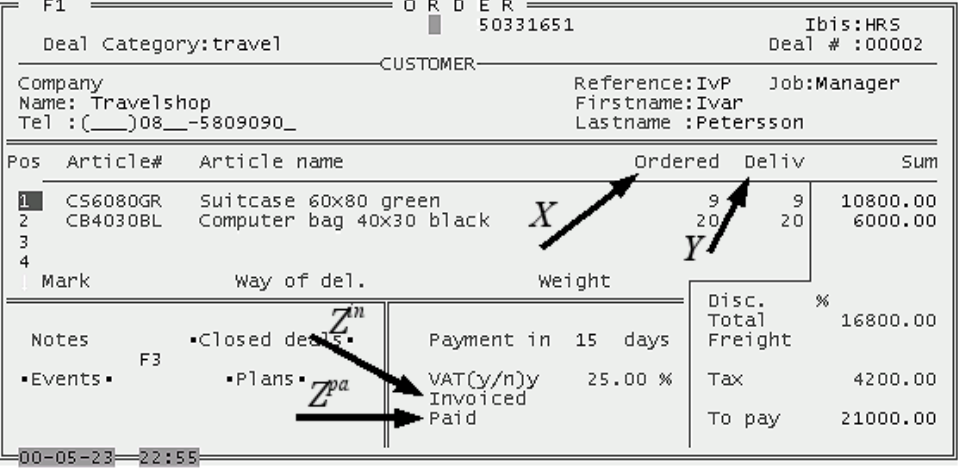
Figure 3. Example of a process state as a mockup screen